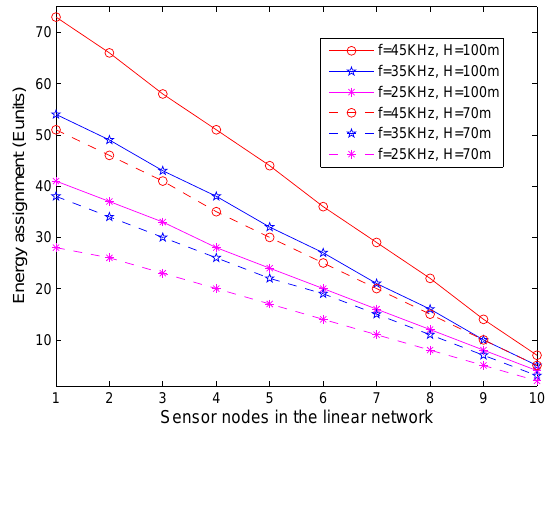
Figure 17. Energy assignment with different frequency in shallow